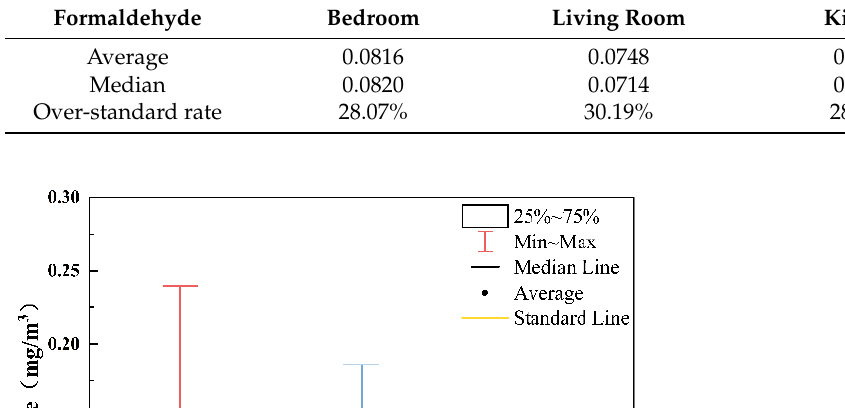
Table 4. Statistical parameters and over-standard rate of formaldehyde in 60 households. Formaldehyde Bedroom Living Room Kitchen Average 0.0816 0.0748 0.0721 Median 0.0820 0.0714 0.0642 Over-standard rate 28.07% 30.19% 28.21%